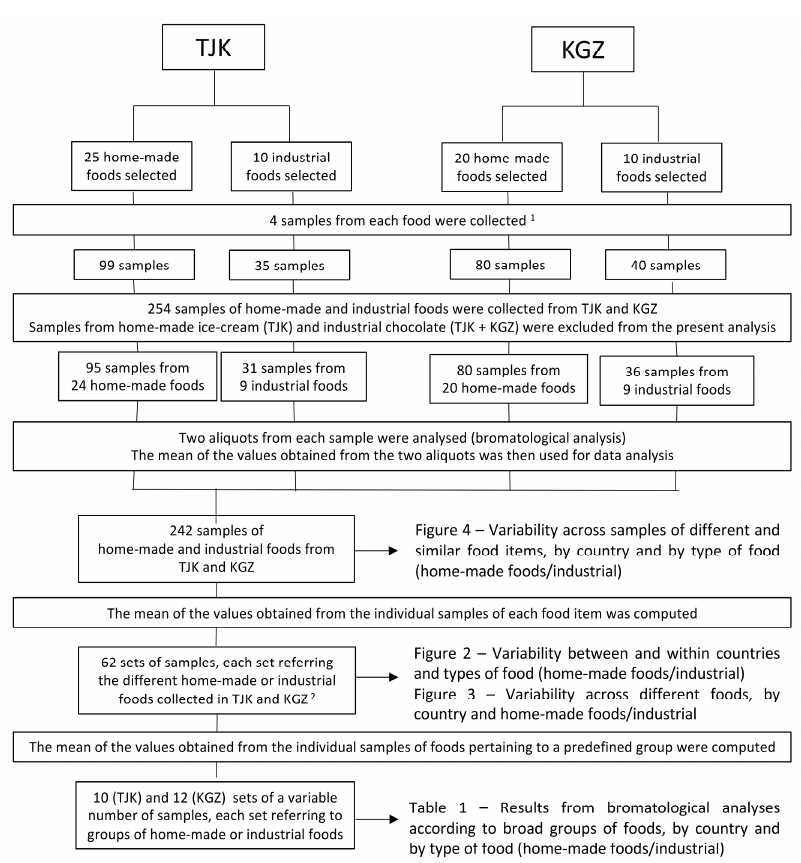
Figure 1. Flow chart of the data analysis process. TJK: Tajikistan; KGZ: Kyrgyzstan. 1 Except for home-made sweet pastries and industrial bread, chips, biscuit rolls, dry bread crumbs and wafers, all from Tajikistan, for which only three samples were collected. 2 The 62 sets of samples correspond to a total of 46 different foods.